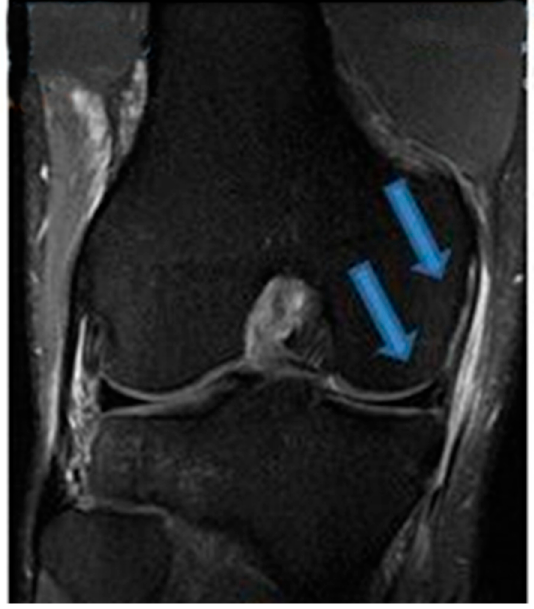
Figure 6. Coronal T2-weighted magnetic resonance imaging of the knee demonstrating injury of the medial meniscus and MCL indicated by blue arrows (20 July 2020).